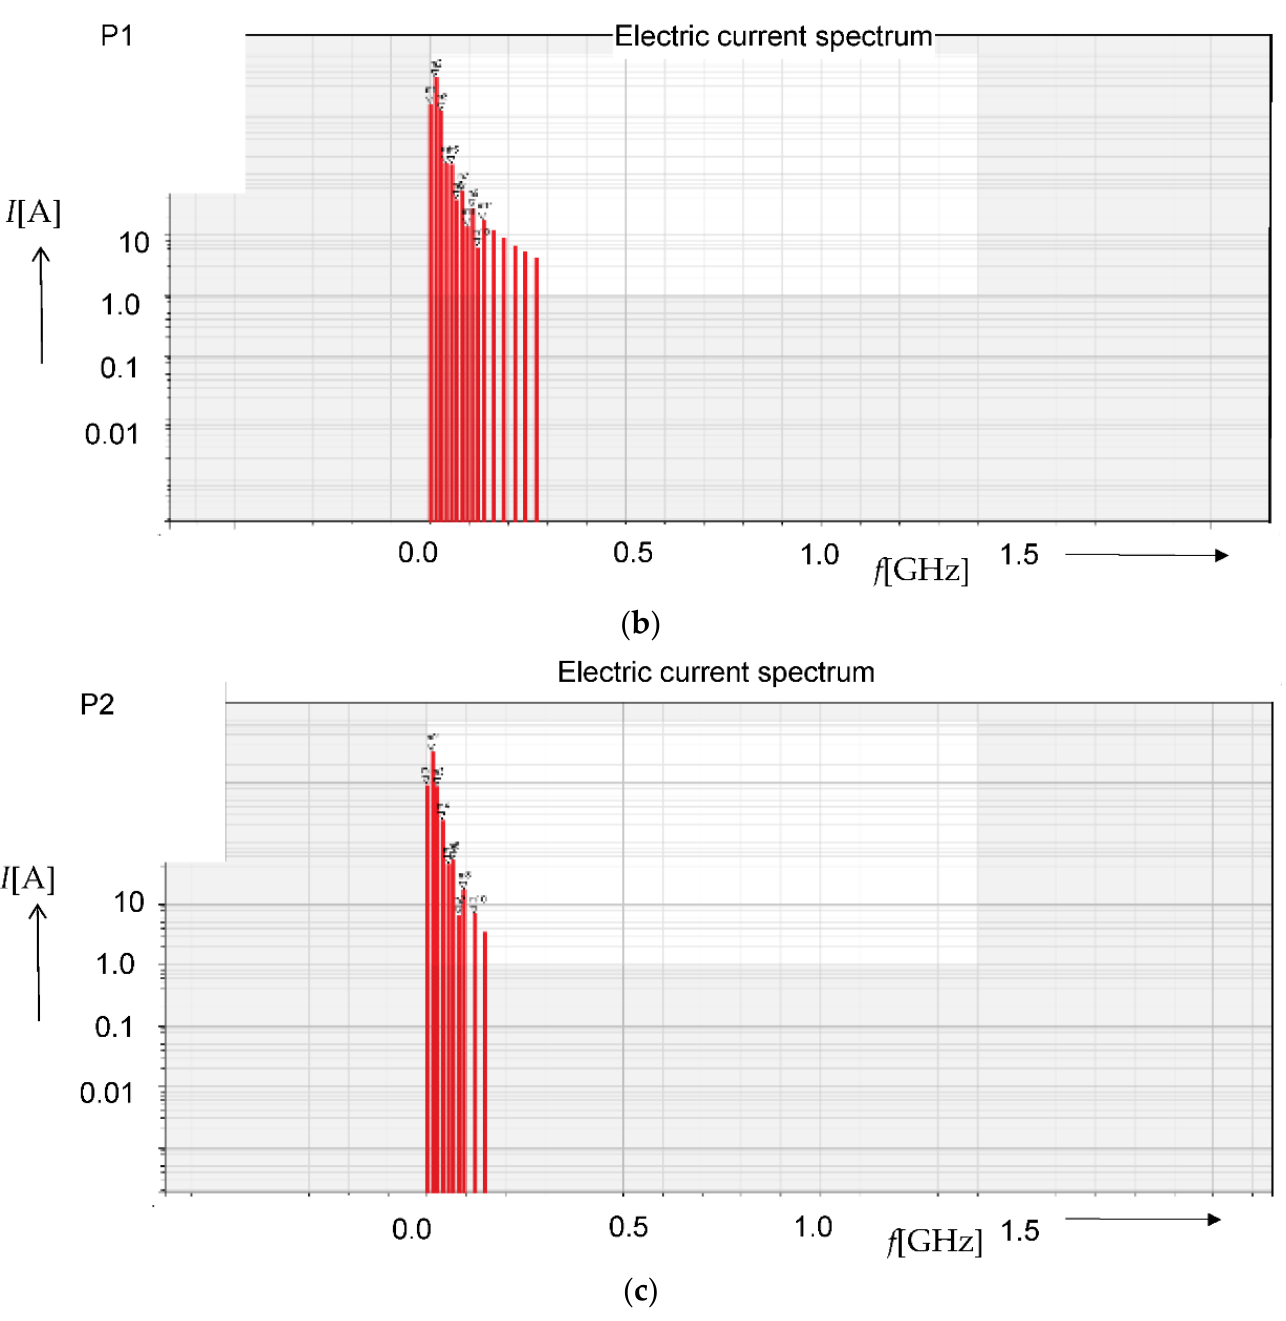
Figure 6. Analyzing and evaluating the geometrical arrangement of the plasma channel and the single-turn electrode: Configuration of the external environment, including the non-linearities of the plasma channel according to formula (21), VA-characteristic, time domain signal, and frequency domain signal, f max = 1.4 GHz: ( a ) A description of the model via concentrated parameters, respecting the above non-linear Formula (21); ( b ) The analyzed spectrum of the behavior of the instantaneous value of the current i (t), relating to functional parameters P1 such as U t = 200 V, U f = 0 V, R ch − = 1 Ω , R ch+ = 5 Ω , R 1 = 1 Ω , U emp = 1500 V, f = 13.56 MHz, U g = 1000 V, I emp = 1500 A. These parameters correspond to a higher concentration of the discharge carriers with respect to the reference setting of the model (Figure 5); ( c ) The analyzed spectrum of the behavior of the instantaneous value of the current i (t), relating to functional parameters P2 such as U t = 200 V, U f = 0 V, R ch − = 1 Ω , R ch+ = 10 Ω , R 1 = 2 Ω , U emp = 1500 V, f = 13.56 MHz, U g = 1000 V, I emp = 1500 A. These parameters correspond to a lower concentration of the discharge carriers with respect to the reference setting of the model.